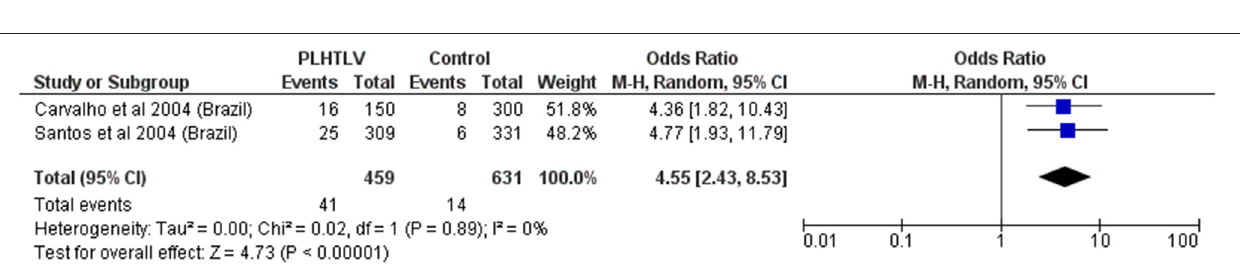
FIGURE 7 | Forest Plot and meta-analysis showing the Odds Ratio Schistosoma mansoni infection in people living with HTLV-1. The boxes and lines indicate the odds ratios (ORs) and their confidence intervals (CIs) for each study. The pooled odds ratio is represented by a black diamond. The size of the blue squares indicates the relative weight of each estimate. Statistical analysis and graph were performed using RevMan 5 Software. Odds Ratio was calculated using Random effects model and Mantel-Haenszel statistical method. Measures of heterogeneity between studies is shown.